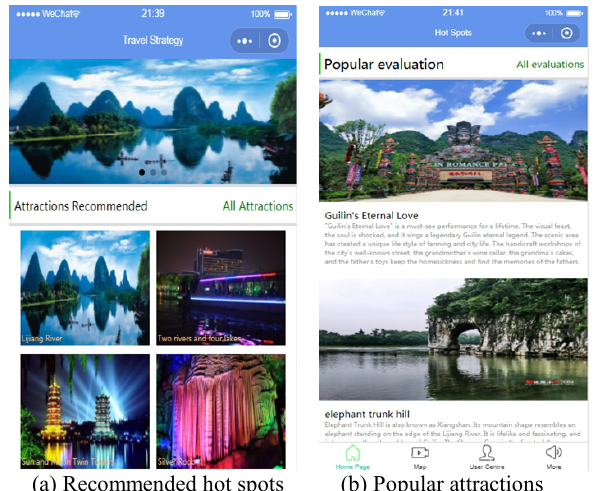
Figure 5. Sightseeing recommendation function